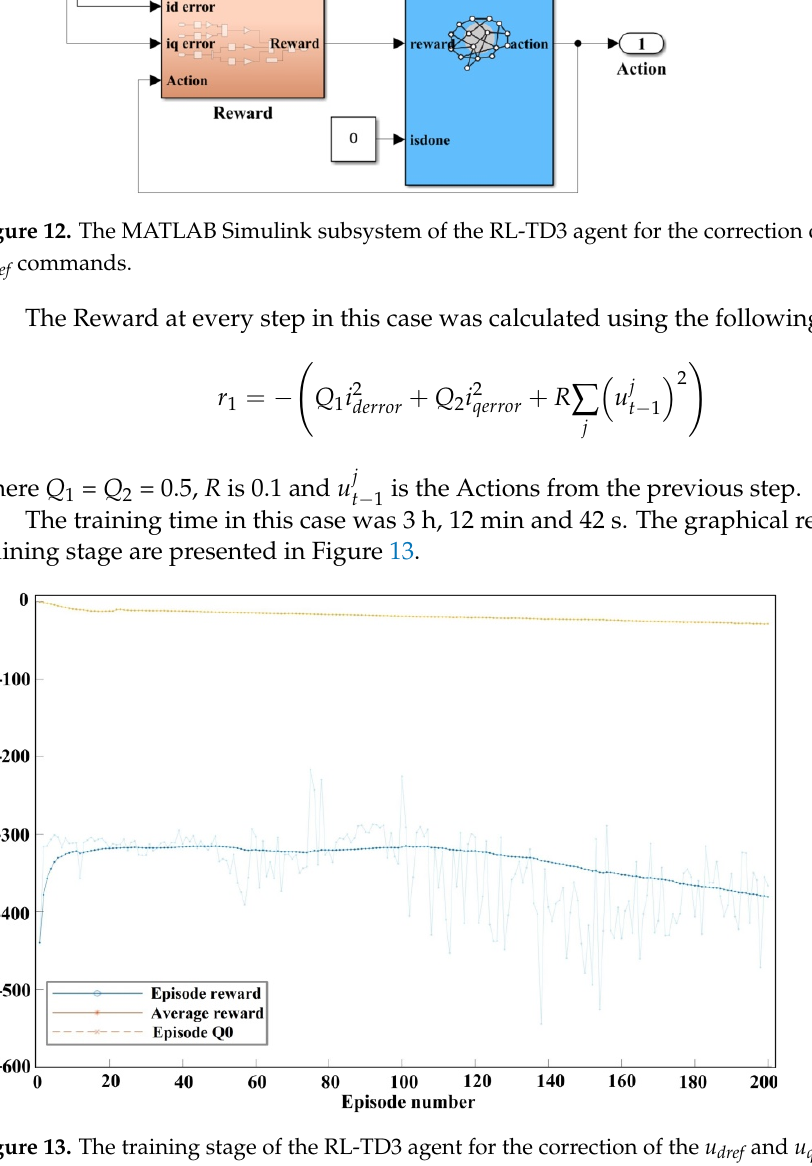
Figure 14. The model MATLAB Simulink implementation of the control system for the GC-PV ar- ray based on PI controllers using the RL-TD3 agent for the correction of the u dref , u qref and i dref com- mands.